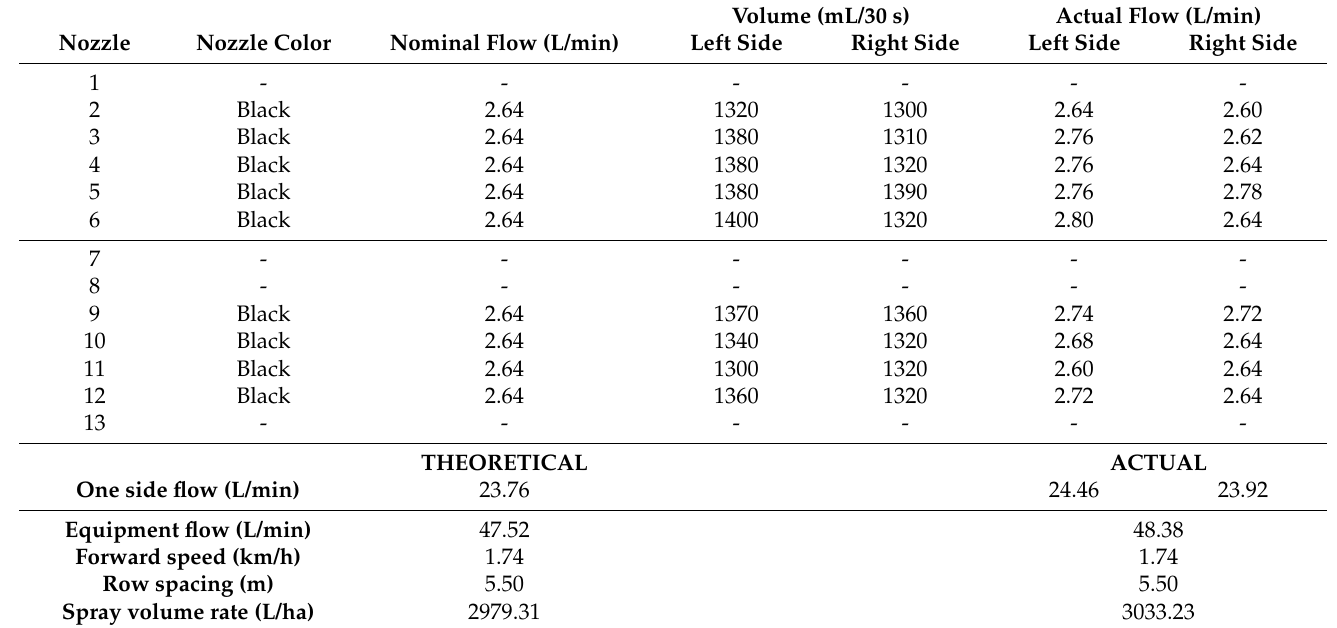
Table A11. Selection and calibration of nozzles for the C2 sprayer, with the following configuration: Adjusted to the vegetation/High & Low fan speed/High spray volume rate/Conventional nozzles (Fine)/Pressure: 9 bar.